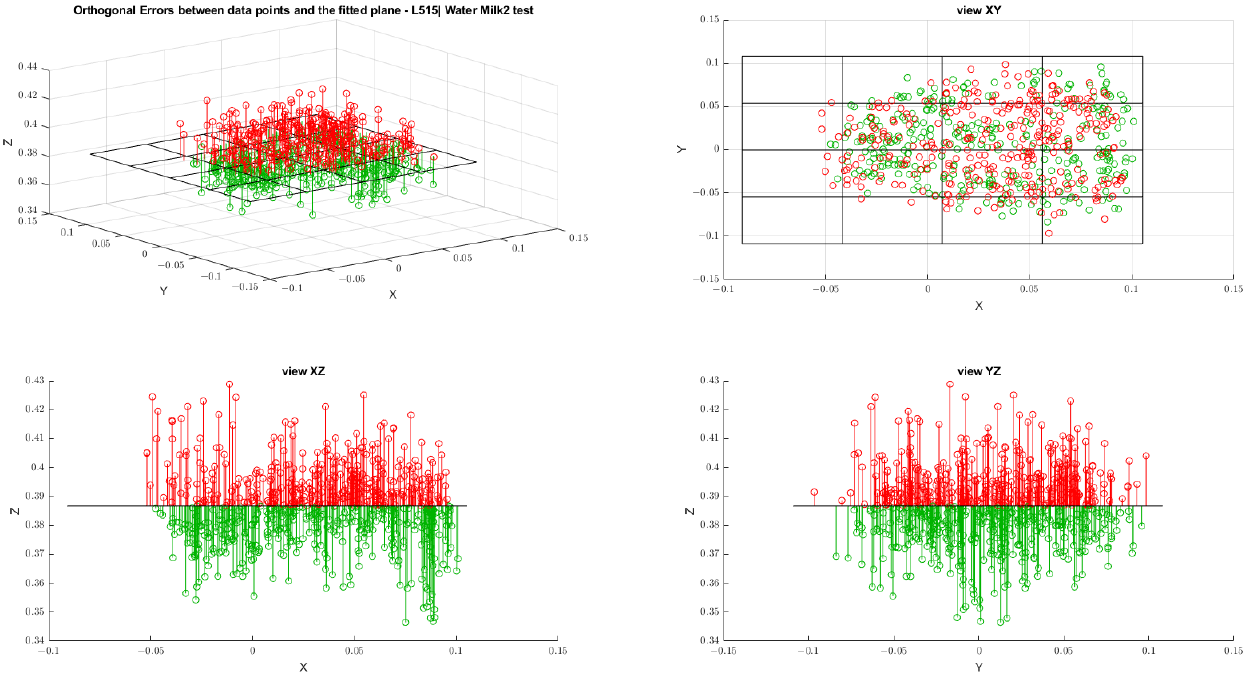
Figure A12. Results of orthogonal errors for the L515 camera referring to the water milk2